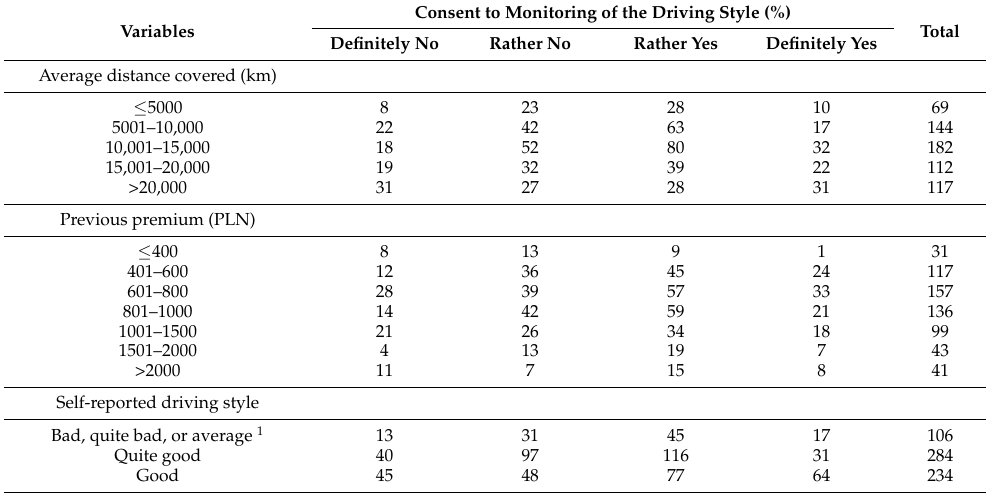
Table 4. Insured persons’ willingness to consent to the monitoring of their driving style, and the characteristics